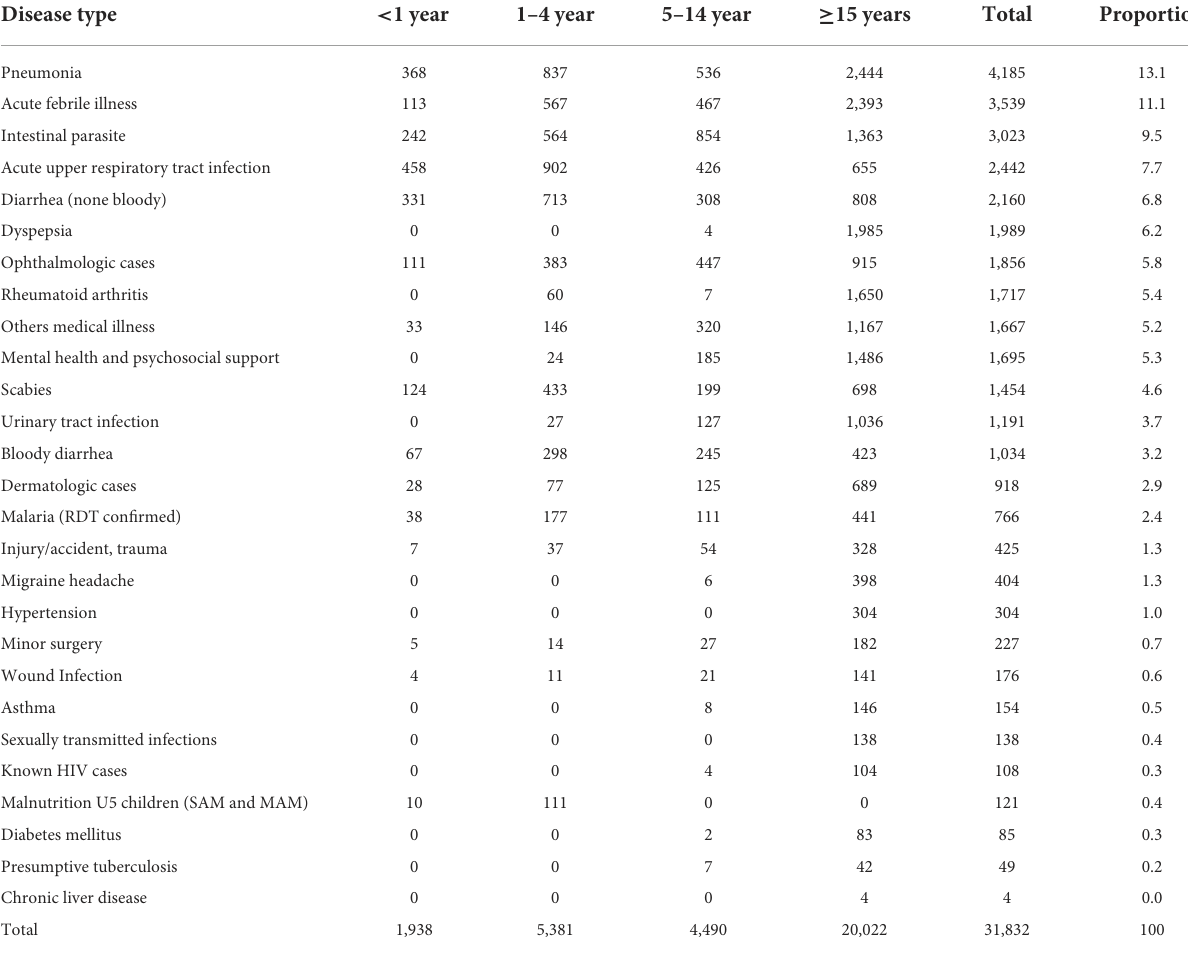
TABLE 1 Total number of morbidities diagnosed in Ranch collective site, Chagni, northwest Ethiopia, November 2020 to June 2021 ( N = 31,832). Disease